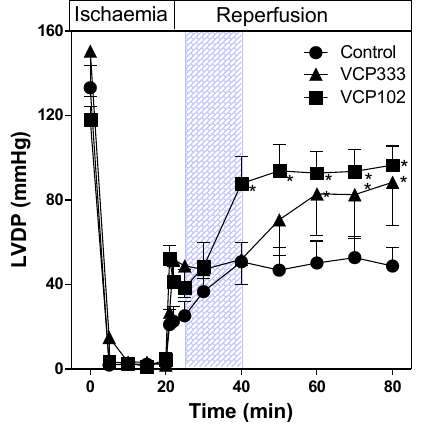
Figure 2. The effect of 15-min allosteric modulator VCP333 (1 μM) or VCP102 (10